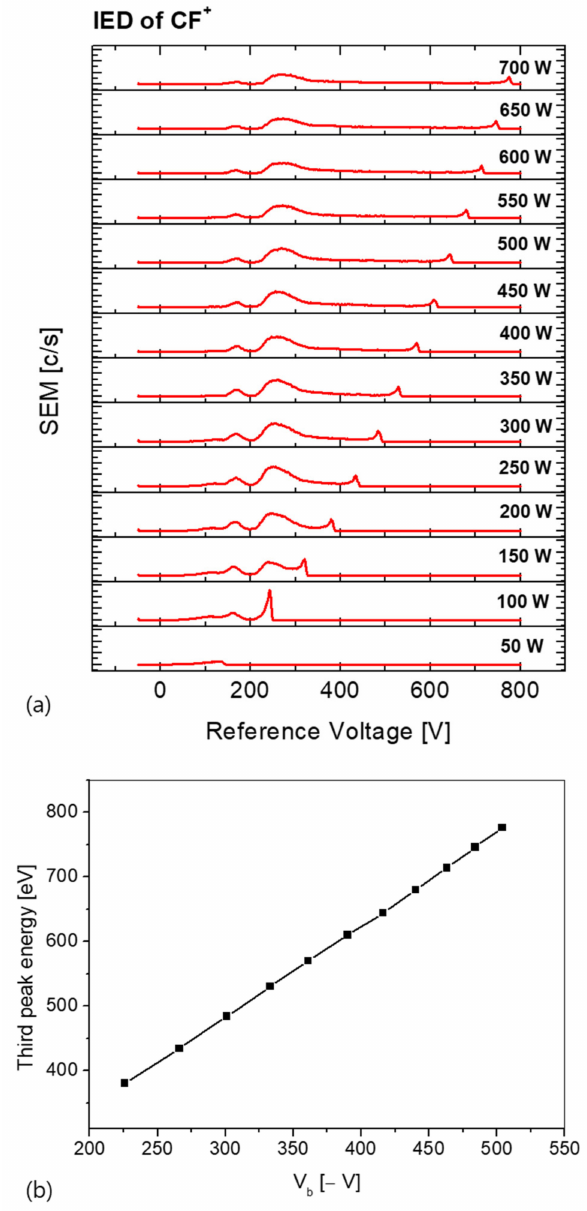
Figure 3. ( a ) IEDs of CF + ions incident on the RF-powered electrode as a function of the RF power, ( b ) Third peak energy of the CF + ions as a function of the self-bias voltage ( V b ), at a fixed pressure of 20 mTorr (C 4 F 8 (40 sccm)/Ar (80